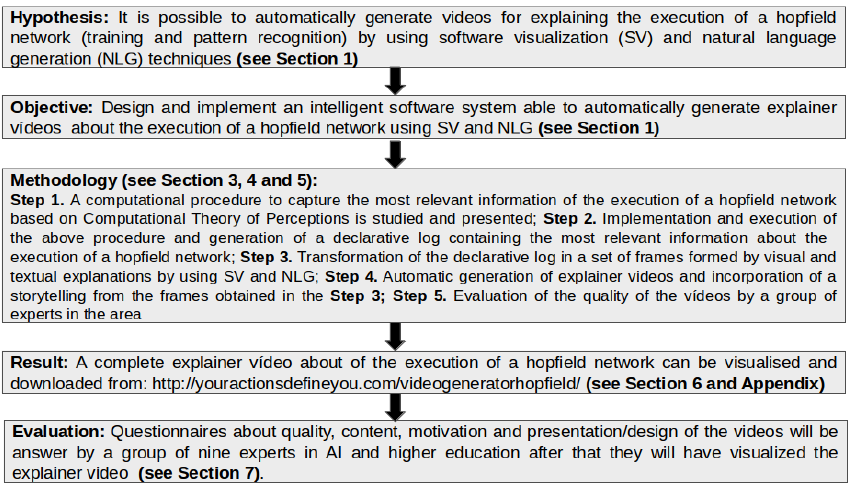
Figure 2. Hypothesis, Objective, Methodology, Result and